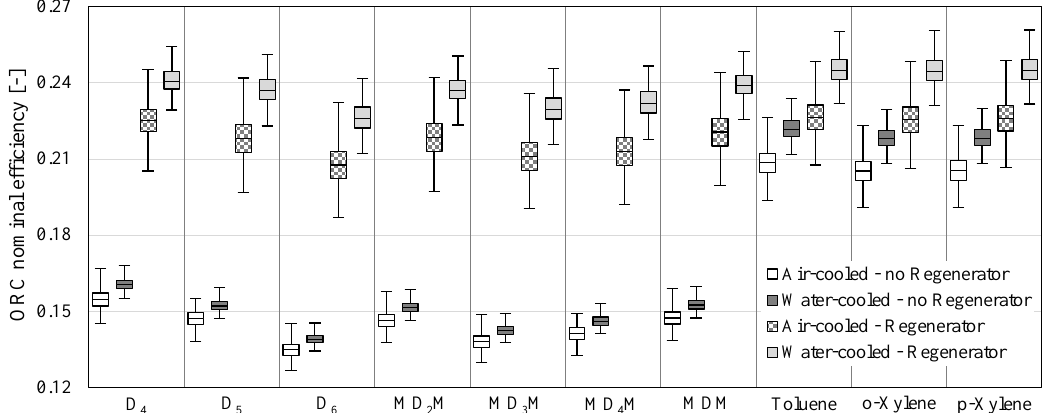
Figure 7. ORC nominal efficiency for different fluids, condenser types and use of regenerator.